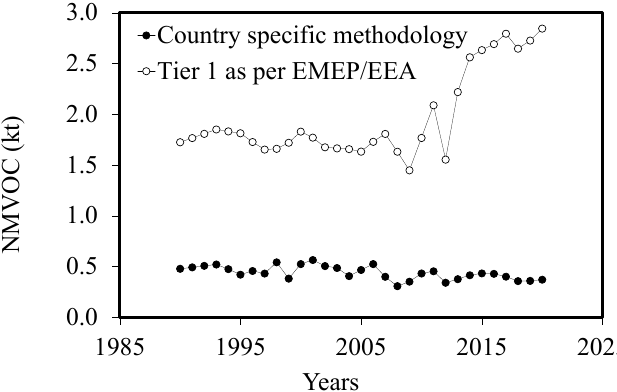
Figure 6. NMVOCs emissions from the food and beverages industry.